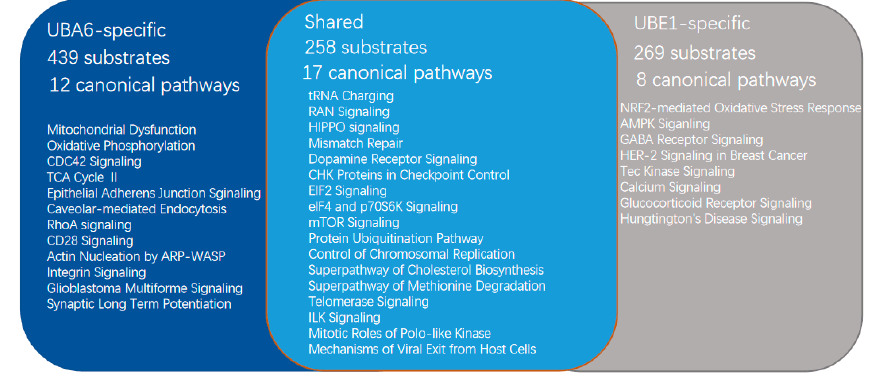
Figure 3. The shared and specific substrates of UBA6 and UBE1 mapped by OUT and Ingenuity Canonical Pathway analyses of the pathways related with the substrates.